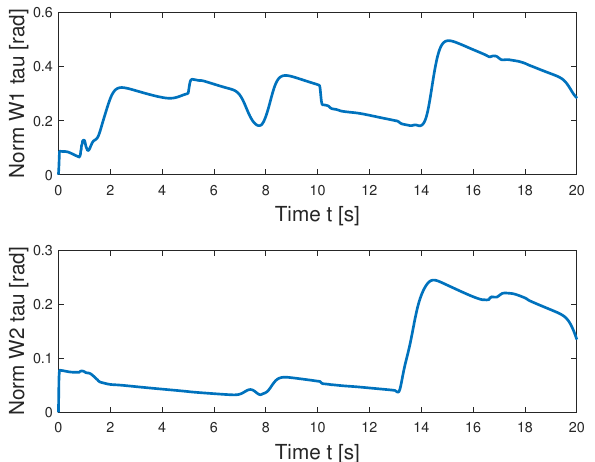
Figure 13. Norms of the adaptation weights W τ (NNs-based